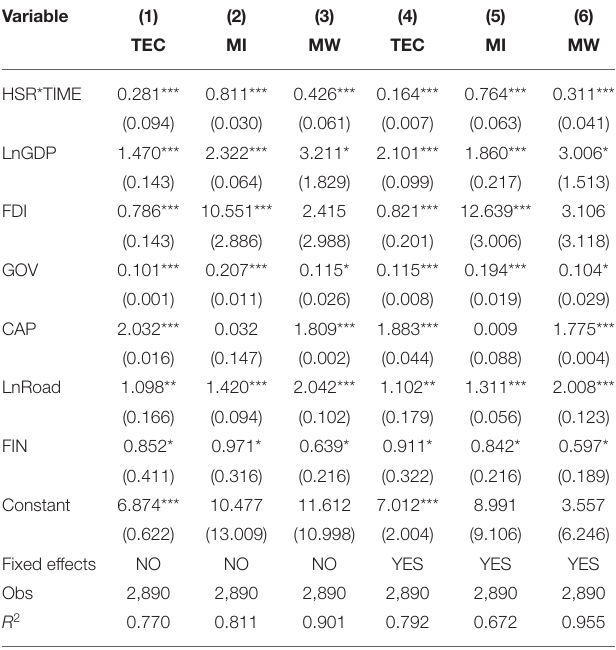
TABLE 1 | Benchmark test.